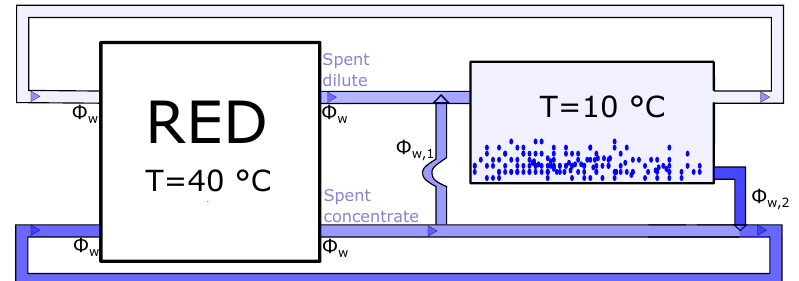
Figure 11. The mass flow in the precipitation system. Φ w,1 is the water flow from the concentrated to the dilute solution, while Φ w,2 is the water flow from dilute to concentrated solution. For no loss of water, Φ w,1 ≡ Φ w,2 .